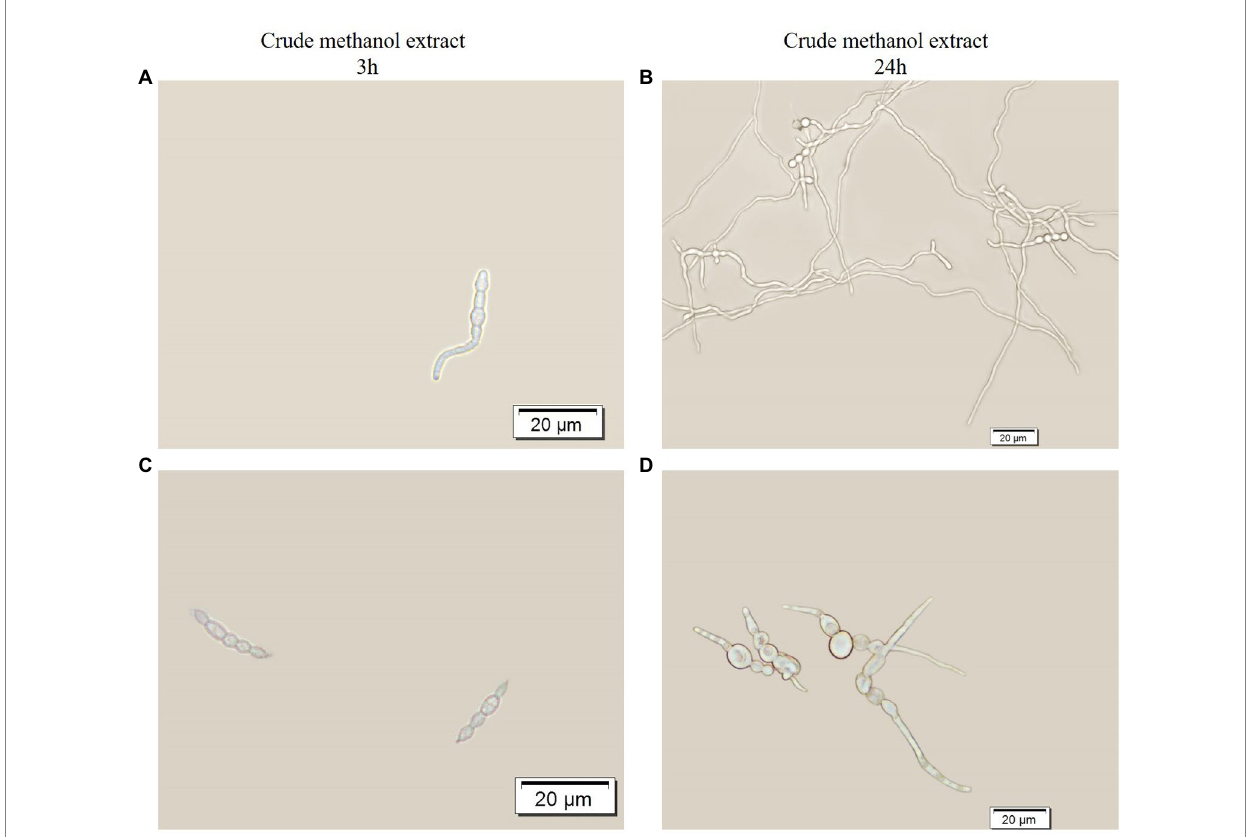
FIGURE 2 Optical micrograph showing the germination of spores with or without treatment with crude methanol extract (100 μ g/ml) for 3 h (A,C) and 24 h (B,D)